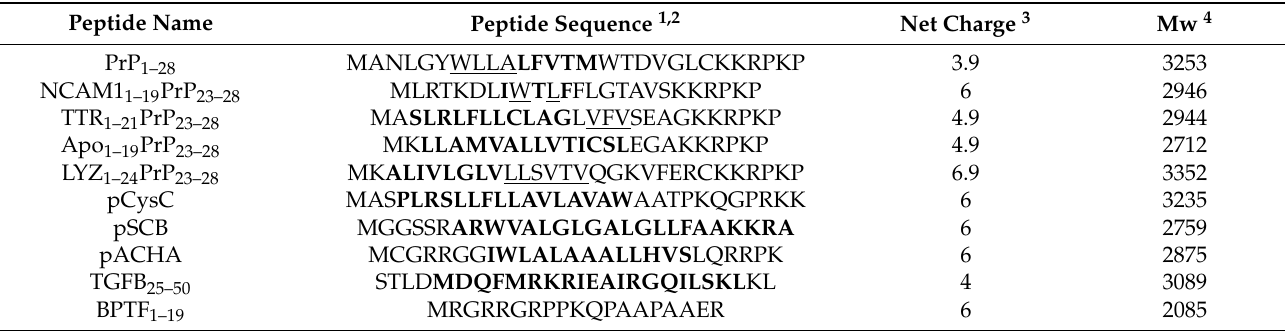
Table 1. Protein-derived peptides used in this work, their predicted structures and net